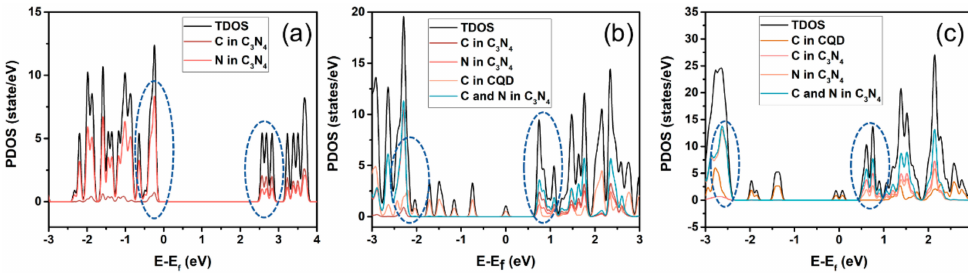
Figure 9. The projected density-of-states for CN ( a ) and CCN ( b and c